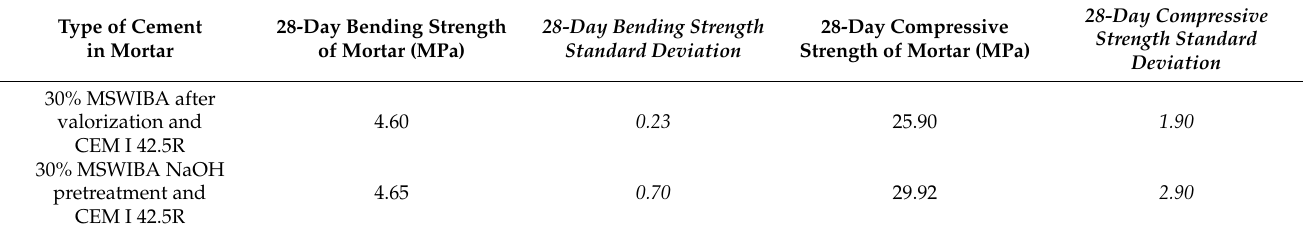
Table 3. Strength test results. MSWIBA accounts for 30% of cement by